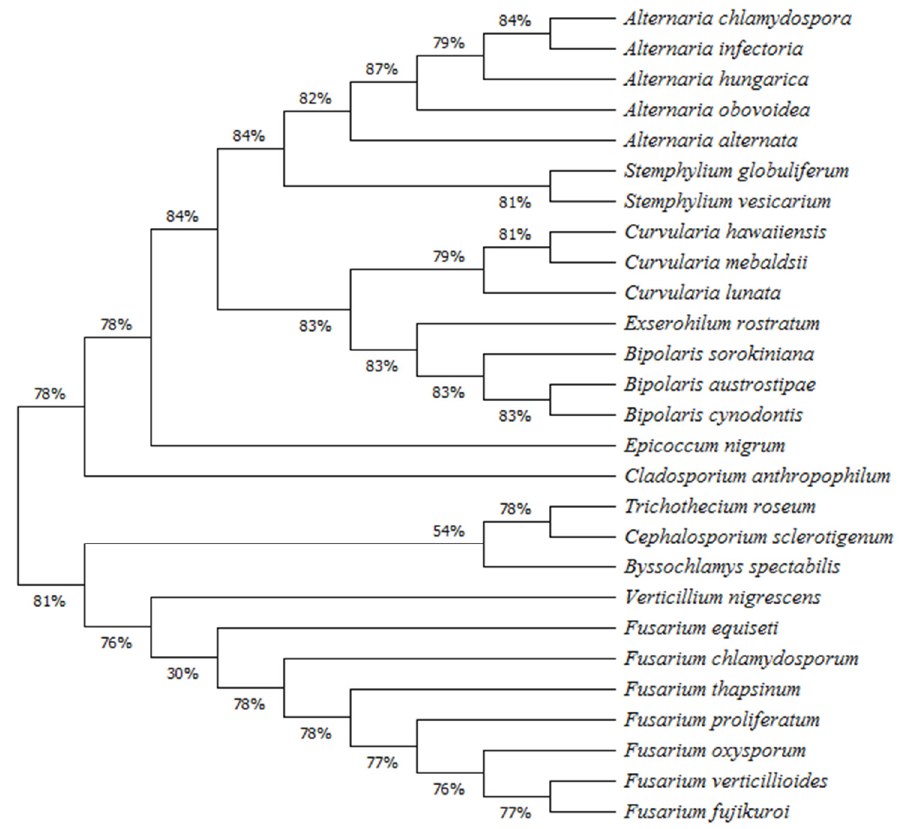
Figure 6. Phylogenetic tree of the seed-borne fungal species identified on wheat grain samples in all 25 wheat-growing governorates of Egypt.